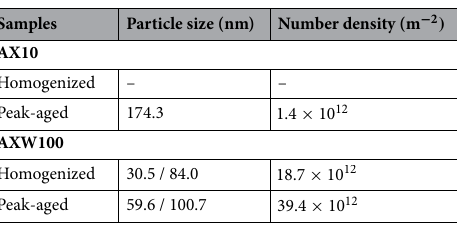
Table 2. Particle size and number density of the precipitates in the homogenized and peak-aged AX10 and AXW100 sheets, respectively.